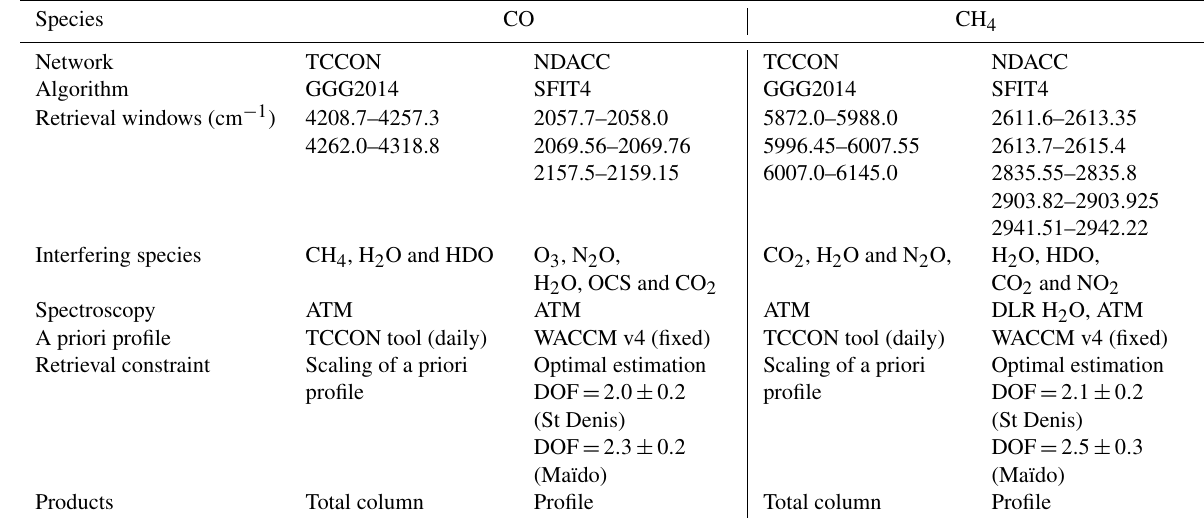
Table 2. NDACC and TCCON CO and CH 4 retrieval strategies for data recorded on Reunion